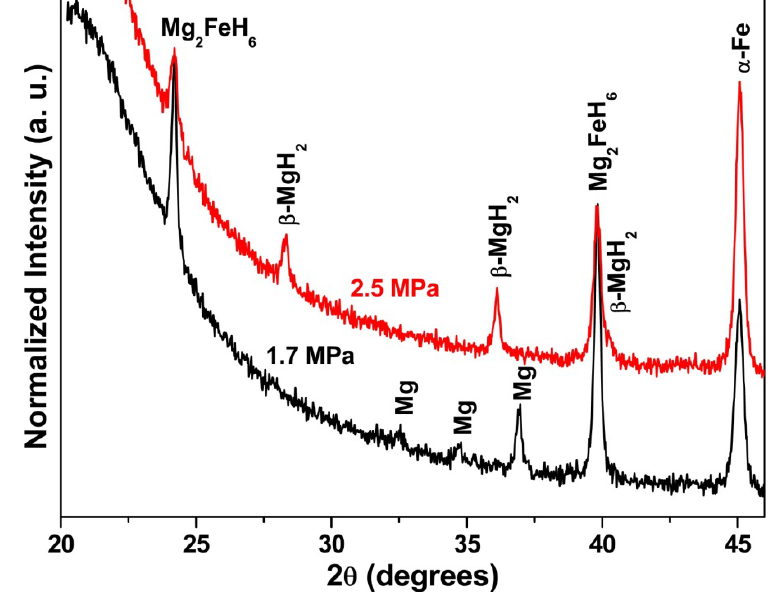
Table 3. Relative quantities and crystallite size of identified phases in the “quenched” samples during hydrogen absorption tests under 1.7 and 2.5 MPa of H Rietveld refinement. In parenthesis are uncertainties on the last significant